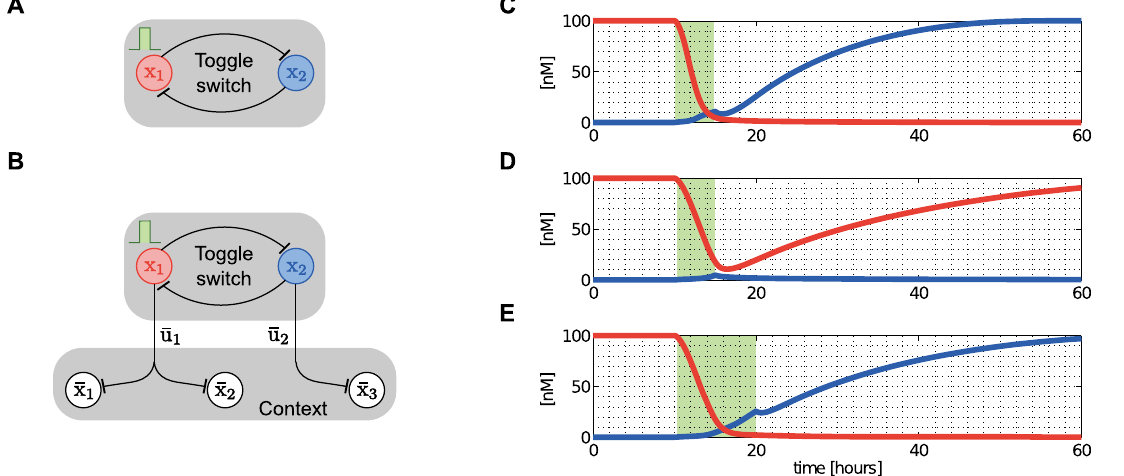
Figure 7. Effects of the context on the switching characteristics of the toggle switch. (A) The toggle switch in isolation. (B) The toggle switch connected to its context [40]. (C) A narrow pulse in f 1 (input perturbation in x 1 , depicted in green) causes the isolated toggle to switch between the two stable equilibria. (D) When connected to the context, the same pulse is insufficient to yield a switch. (E) With a wider pulse, the switching is restored (however, dynamics are slower compared to the isolated case). Simulation parameters: both x 1 and x 2 bind as